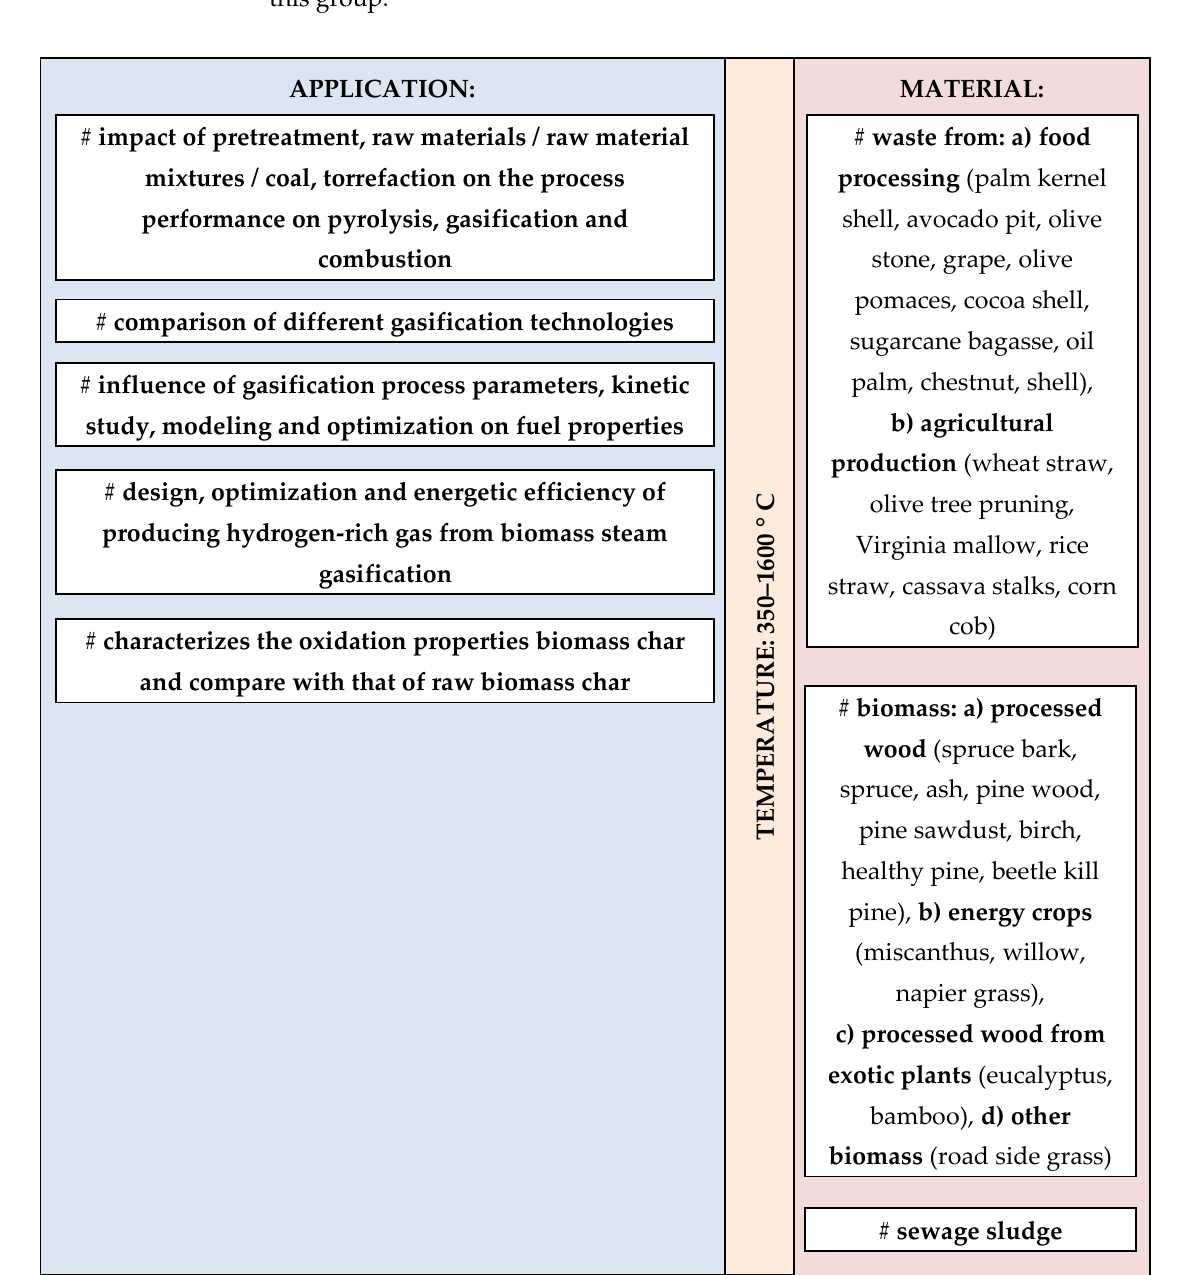
Figure 13. Main research topics and process parameters—gasification and co-combustion. The last group concerned the other topics related to the process of thermal biomass processing, which thematically did not fit directly into the previously mentioned (Figure 14, Appendix A: Table A5). There were 35 publications in this group.